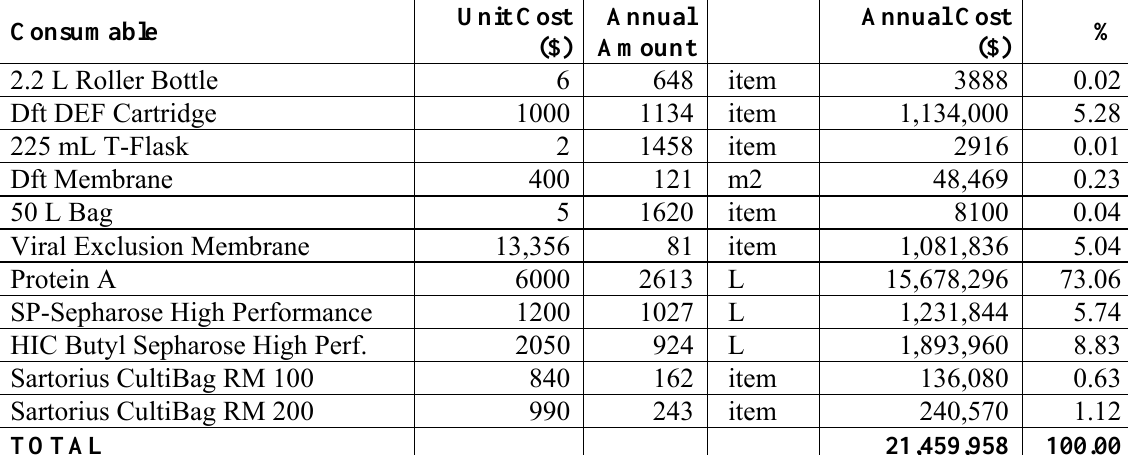
Table 5. Consumables Cost Breakdown (Year 2013 prices in US